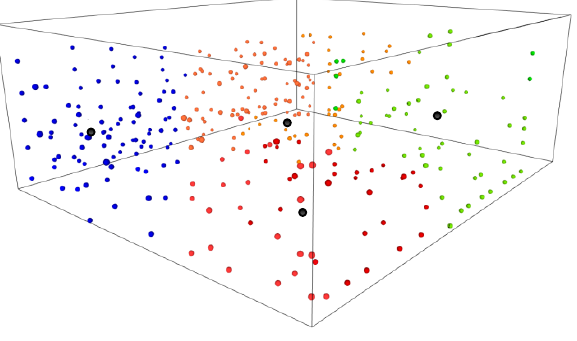
Figure 3. Sensors location in urban area